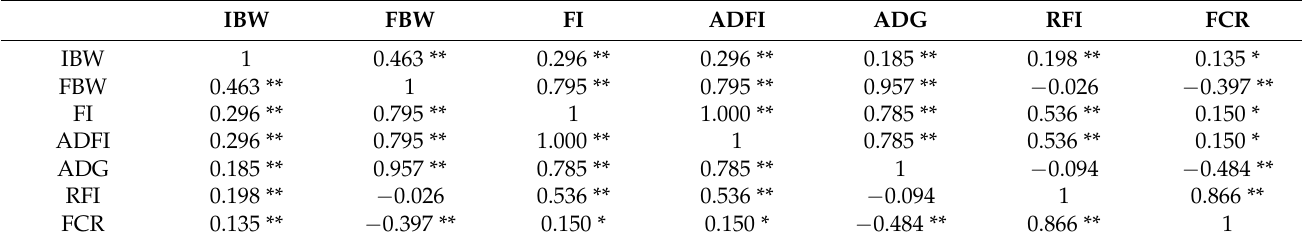
Table 2. Correlation coefficients (r) between feed efficiency.